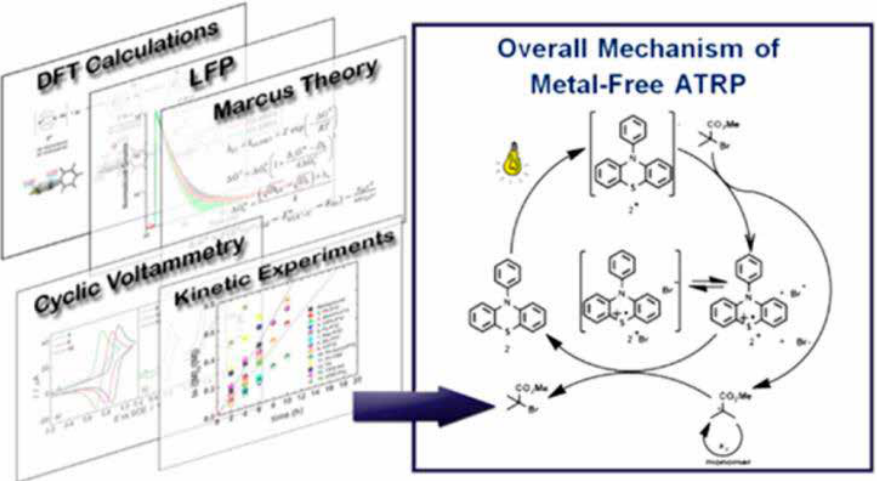
Figure 2: Mechanism of photoinduced metal-free atom transfer radical polymerization through both experimental and computational studies. (Adapted with permission from Ref. [38]).